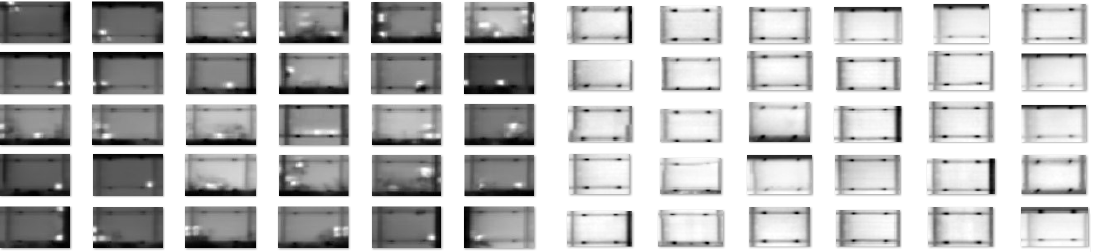
Figure 6. Positive samples of hotspots ( left ) and negative samples ( right ) from our aggregated PV dataset, here depicted as grayscale images.